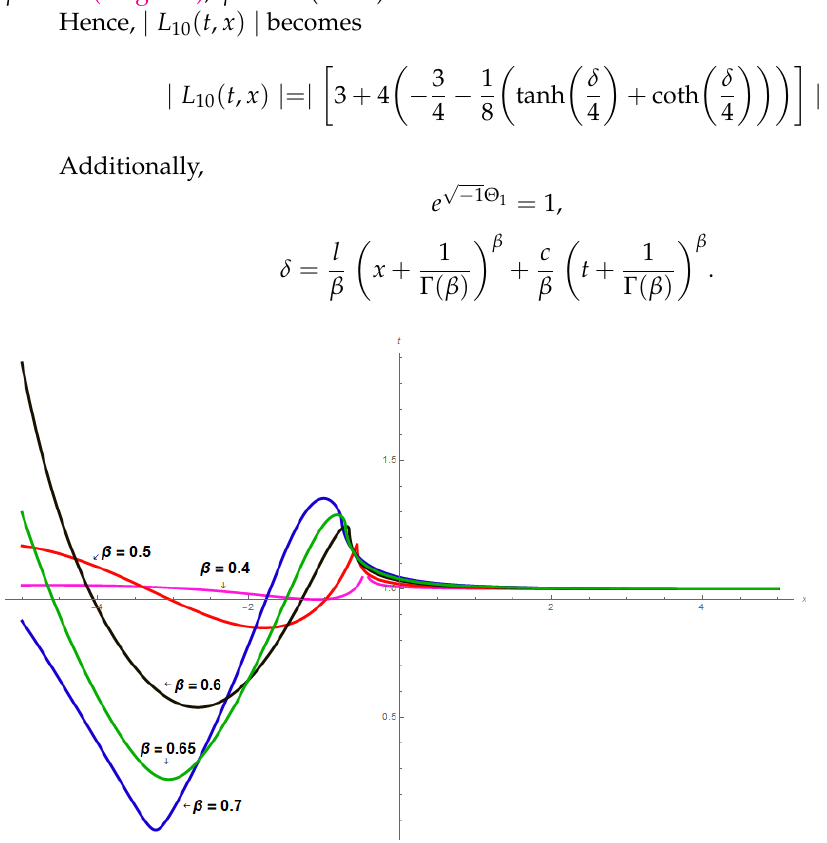
solitary-wave solutions. Here is a visual showing a 2D plot spanning the range ( − 0.5, 0.5 ) for various values of β associated with parameters, such as ρ = e , l = s 1 = 1 , µ 1 = 1, ζ 1 = 2, ν 1 = 3, β = 0.5 (red), β = 0.7 (blue), β = 0.65 (green), 2 β = 0.4 (magenta), β = 0.6 (black).